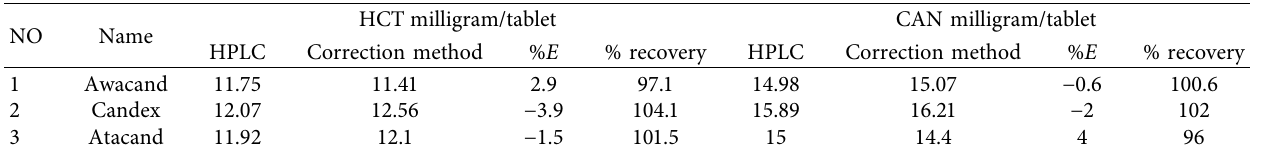
Table 18: Statistical comparison between the correction absorbance method and HPLC.